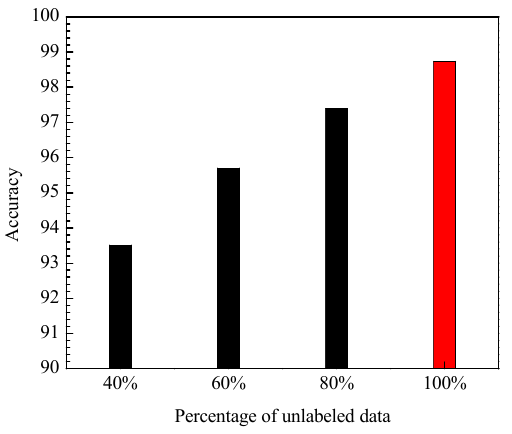
Figure 8. Accuracy of PCA-DAS4VM under different numbers of labeled data.